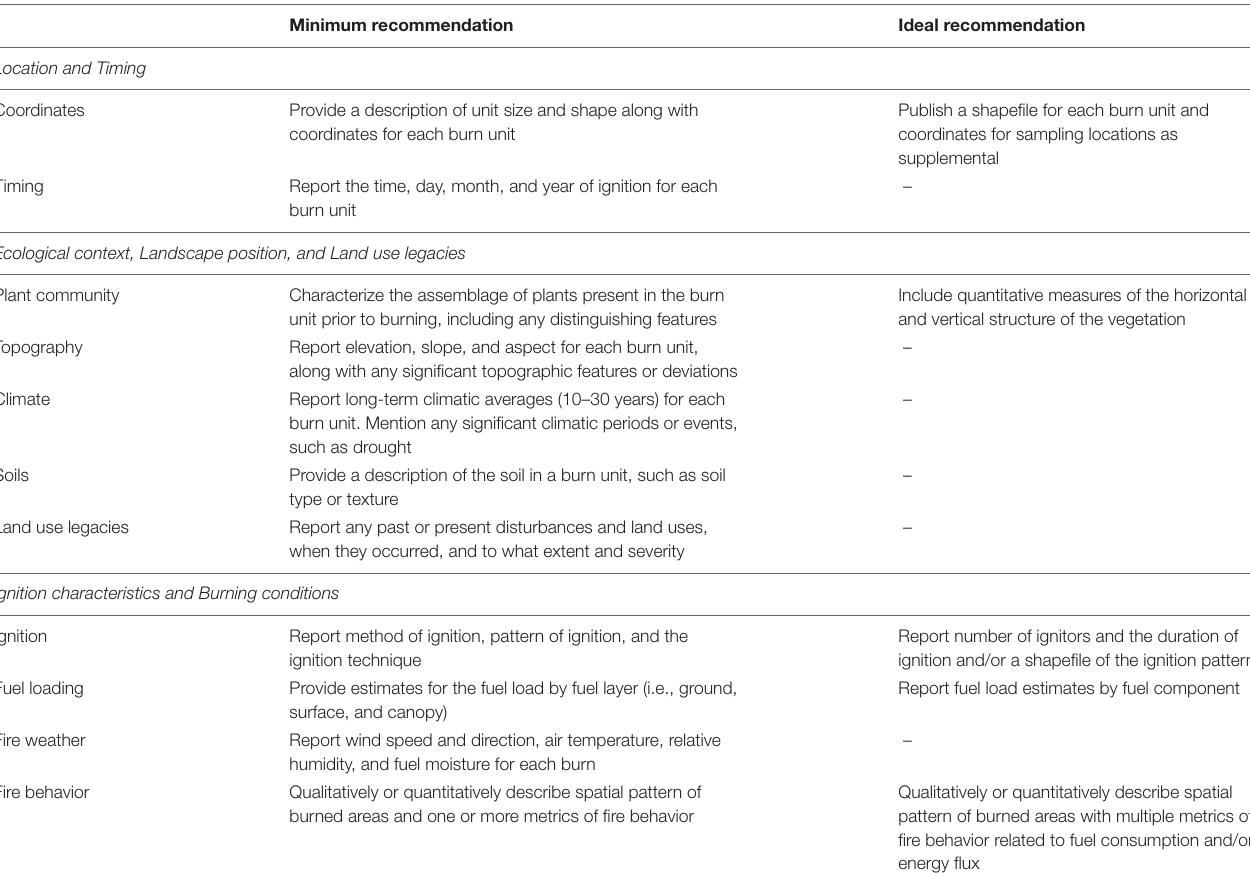
TABLE 2 | Suggested best practices for reporting on ecological prescribed fire